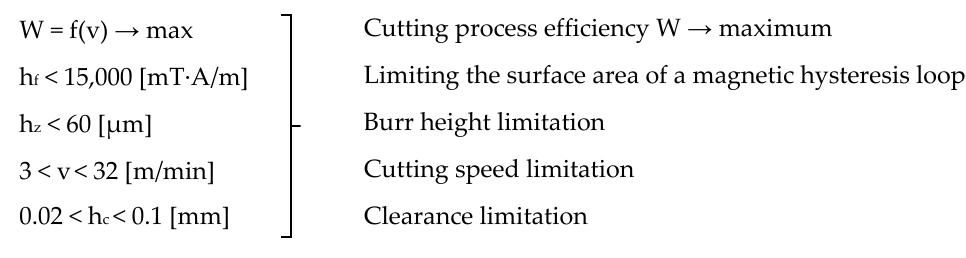
Figure 17. Graphical optimization of the cutting process. 5. Practical Application of Analysis Results The conducted fragmentary experimental research, results analysis, and mul- ti-criteria optimization of the cutting process enabled the development of an effective numerical model of the process for blanking parts for electric machines. Using the results, a computer model was developed with the finite element method for the process of blanking parts for the construction of an electrical transformer from grain-oriented elec- trical sheets. The developed model is aimed at verifying the results of fragmentary tests and implementing research conclusions into production. The industrial implementation of the research results will make it possible to obtain a polyoptimal product for mechan- ical (manufacturing) and electrical (efficiency of electrical devices) purposes. Figure 18 shows the FEM model of the sheet metal blanking process for the transformer core.